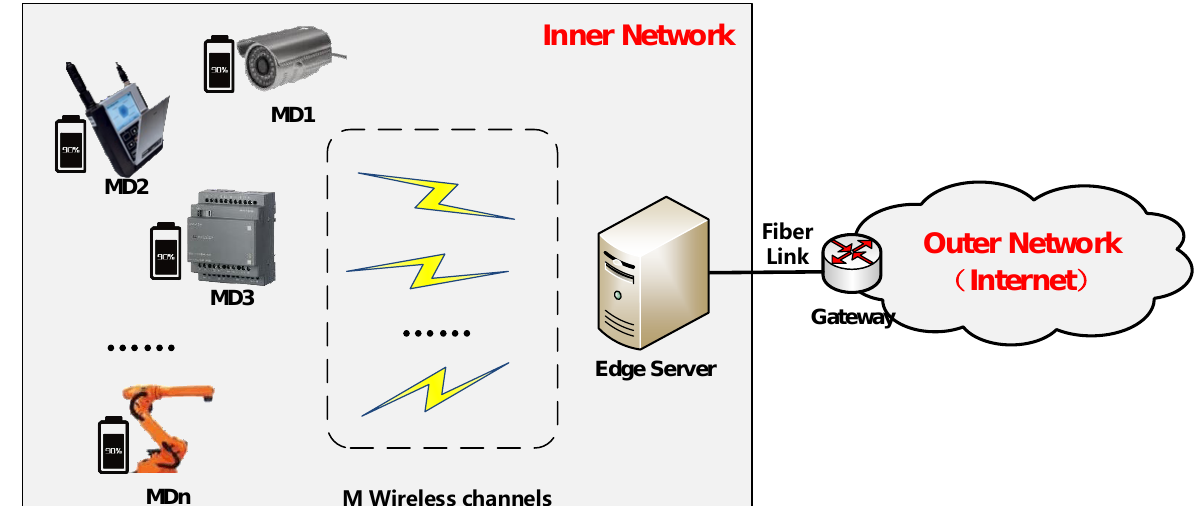
Figure 1. The scenario of task offloading with reliability of MDs in MEC of the Industrial